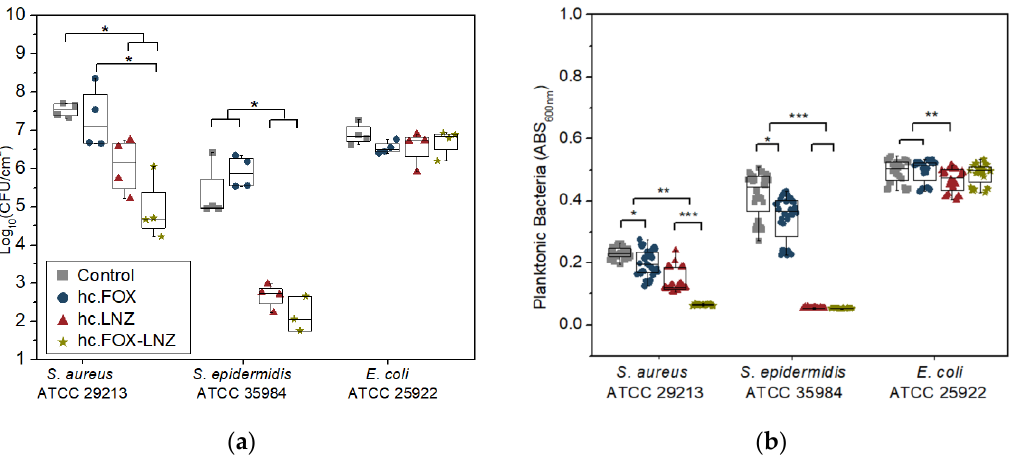
Figure 8. Quantification of ( a ) biofilms and ( b ) non-adherent planktonic bacteria of titanium pieces coated with Control, hc.FOX, hc.LNZ, and hc.FOX-LNZ. Data are represented as median and interquartile range of the log 10 (CFU/cm 2 ) estimated by ( a ) drop plate and ( b ) absorbances (absorbance units, AU) obtained in four independent experiments. * p -value < 0.05, ** p -value < 0.01, *** p -value < 0.001 for Wilcoxon test.